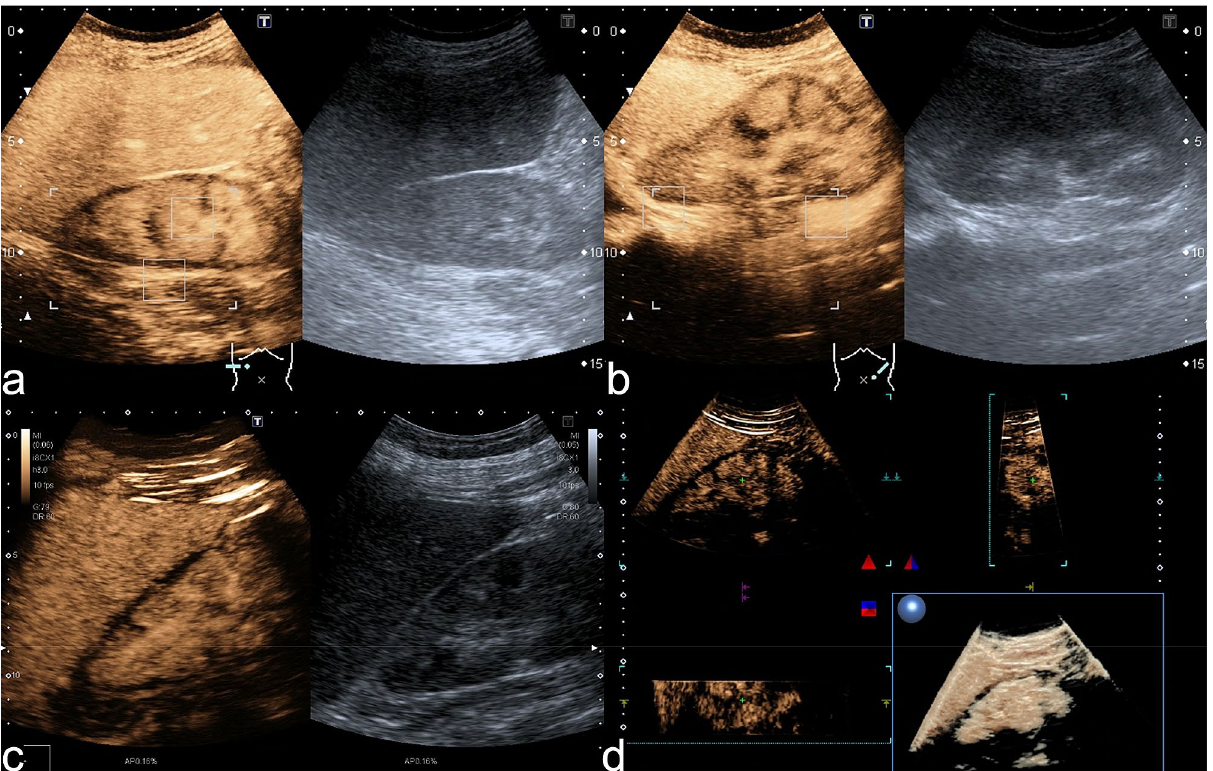
Figure 2. Extent of RCN in CEUS. ( a ) CEUS (0:56 min) of the right kidney in a female patient showing an uninterrupted nonenhancing circular subcapsular rim while B-mode US shows no subcapsular alteration. Note simultaneous enhancement of the medullary pyramids. This pattern is known as the reverse rim sign. ( b ) CEUS (1:20 min) and US image of the left kidney of the same patient consistent with bilateral RCN. ( c ) CEUS (2:15 min) of the right kidney in a different patient showing a subcapsular non-enhancing rim of variable width, especially at the upper pole. ( d ) Same patient as in ( c ). The 3D rendering of the right kidney during CEUS proves the variation in the with of the nonenhancing subcapsular